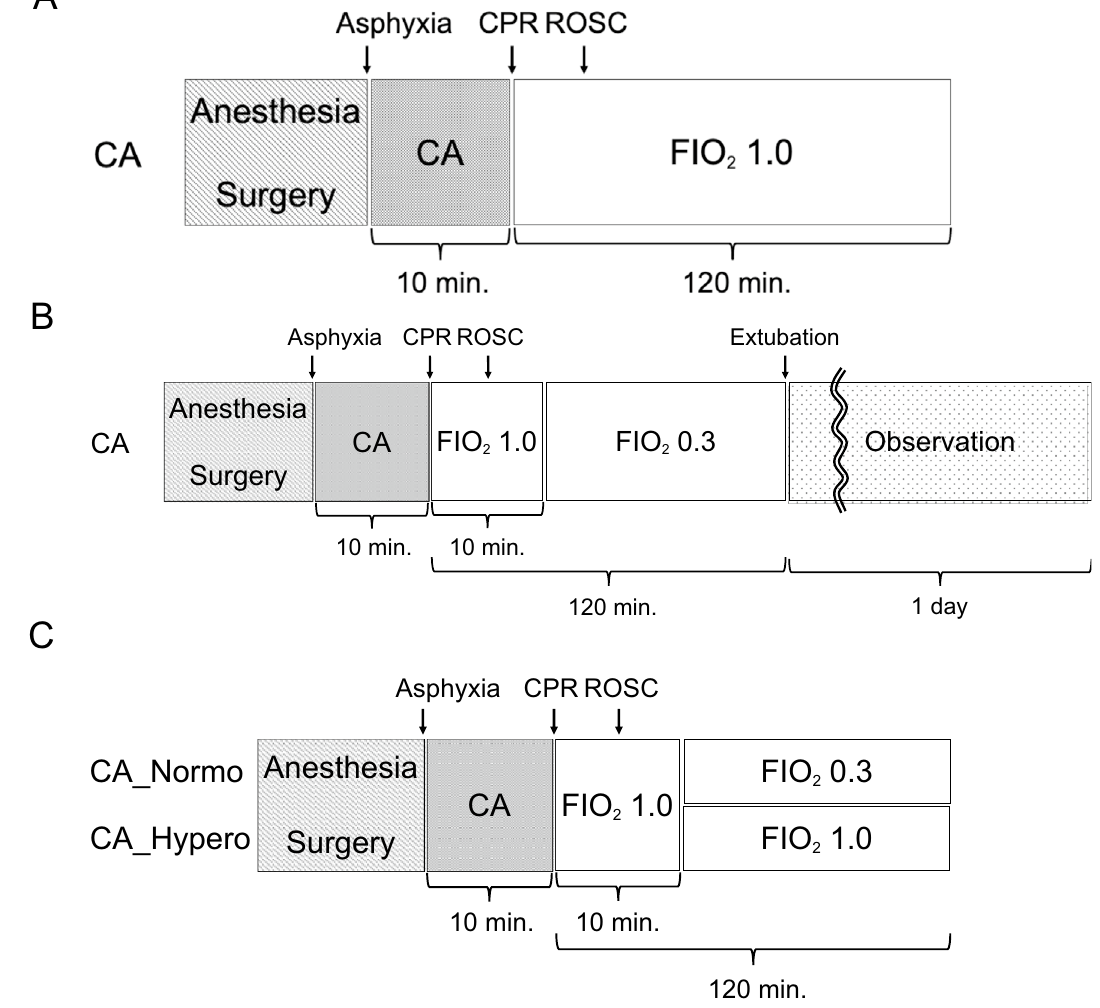
Figure 1. Animal protocols for each study. ( A ) Animal protocol for dihydroethidium (DHE) assay. Tissues of rats 120 min after successful resuscitation from a 10-min asphyxia arrest treated with inhaled 100% O 2 were collected and applied to cryosection, followed by DHE staining. DHE derived 2-hydroxyethidium (2-OH-E + ) fluorescence was compared between CA group and non-interventional control rat tissues. ( B ) Animal protocol for physiological assessment. Rats 120 min after successful resuscitation from a 10 min asphyxia arrest treated with inhaled 30% O 2 were extubated and observed until 24 h after CPR. For the assessment of brain function, modified neurological deficient score (mNDS) was evaluated. mNDS before anesthesia (Baseline) and 24 h after CA were compared. For the assessment of heart function, echocardiography was performed to compare ejection fractioning (EF) and fractional shortening (FS) between baseline and 24 h after CA. For the assessment of lung injury, lung wet to dry (W/D) weight ratio was measured. Wet lung weight was measured just after extraction, and dry lung weight was measured after drying over for 1 week in a 37 ℃ oven. Non-interventional control rat lung and 24 h after CA rat lung were compared. ( C ) Animal protocol for real time PCR. Similar with the protocols above, rats were assigned into 2 groups: (1) 120 min after successful resuscitation from 10 min asphyxia arrest treated with inhaled 30% O 2 (CA_Normo) and (2) those with inhaled 100% O 2 (CA_Hypero). In CA_Normo group, 10 min after CPR inhaled oxygen concentration was changed to 30%, whereas inhaled oxygen concentration was kept 100% in CA_Hypero group. At 2 h after CPR, the brain, heart, and lung were collected and mRNA extraction, followed by cDNA synthesis and real-time PCR were performed. Additionally, tissues from non-interventional control rat group were also collected for reference of mRNA gene